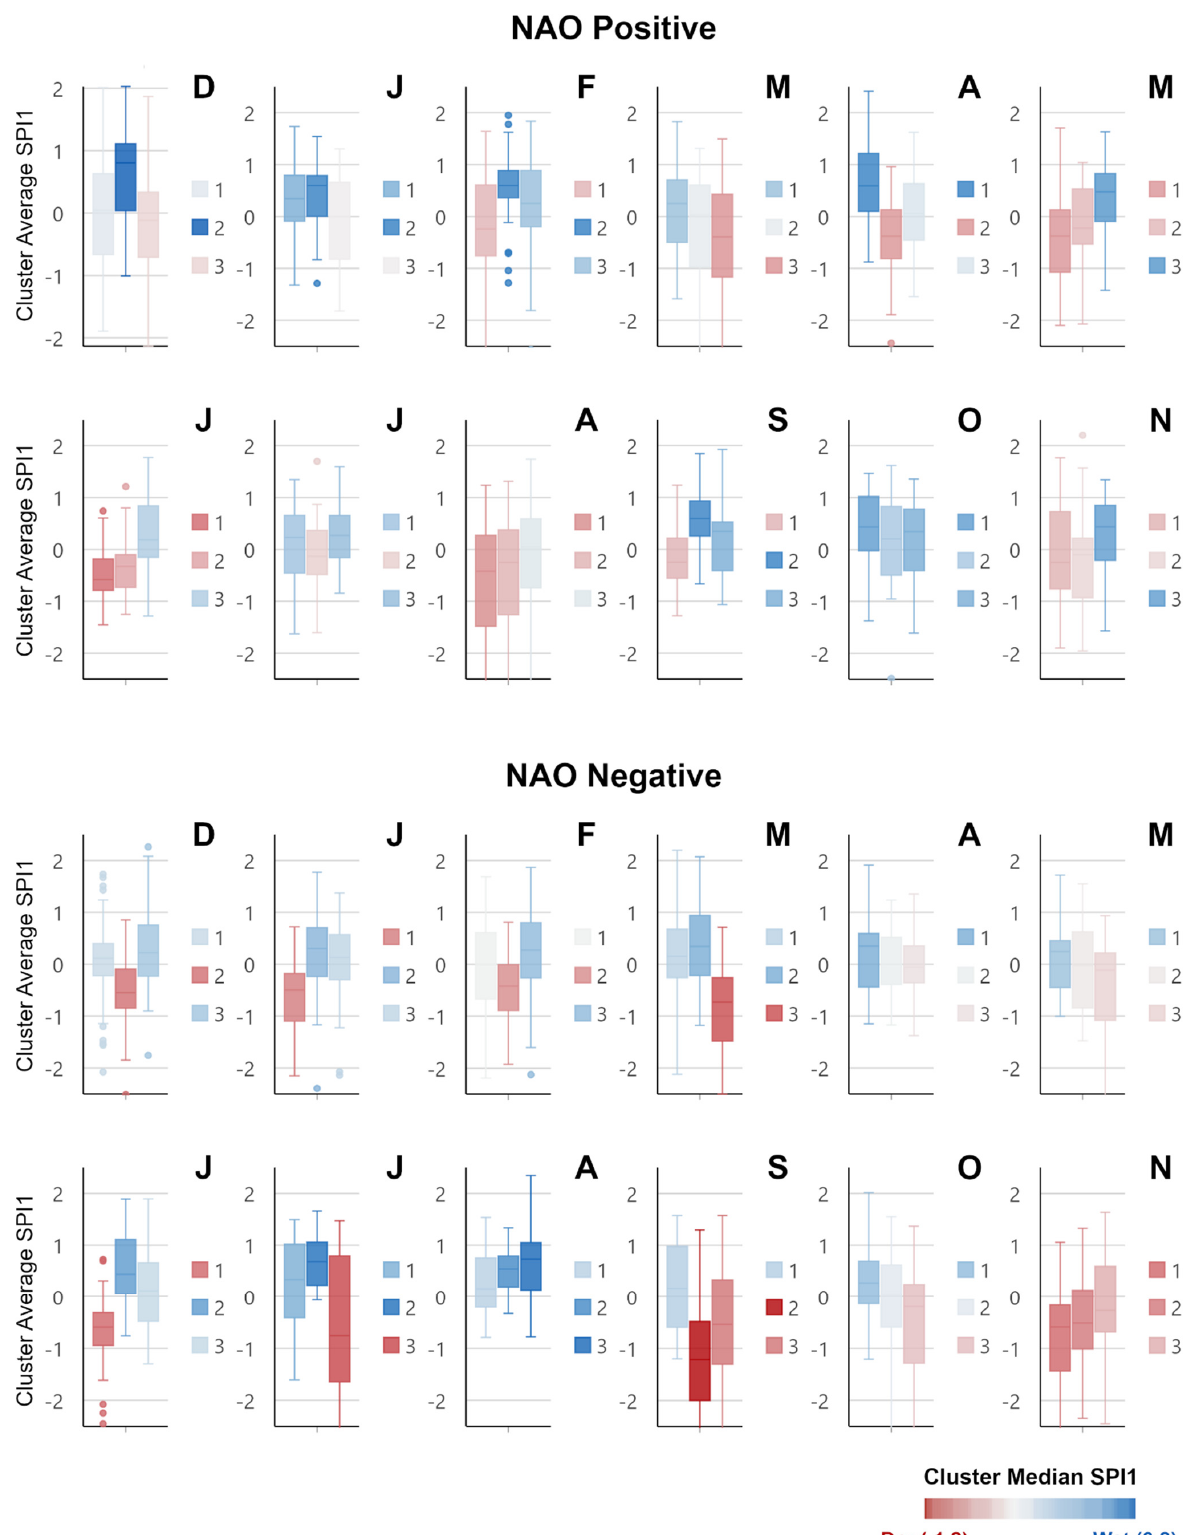
Figure 9. Box plots representing the distribution of cluster median SPI-1 values for the space-time clusters mapped in Figures 7 and 8. As with Figures 7 and 8 the box plots are coloured based on the median SPI-1 value of the cluster in space and time. Individual points represent outlier values.